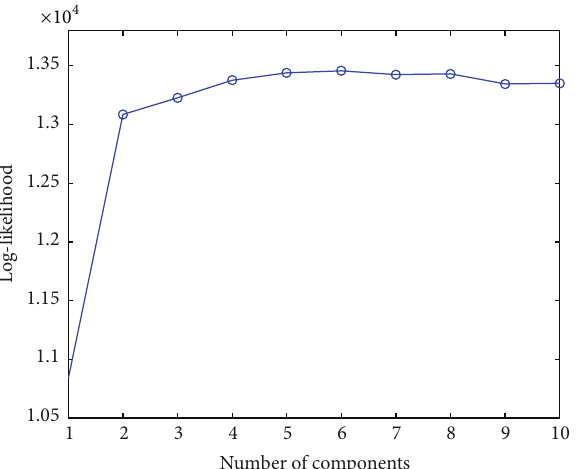
Figure 8: Log-likelihood including the penalty